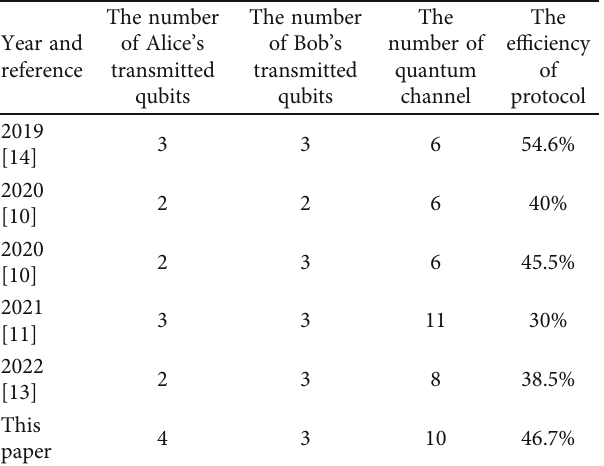
Table 4: Comparing the e ffi ciency of di ff erent